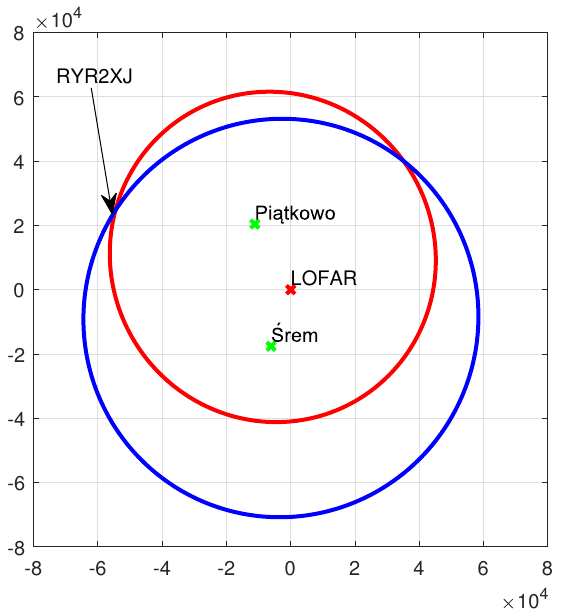
Figure 24. Two ellipses computed based on the RYR2XJ plane’s bistatic ranges from two transmitter